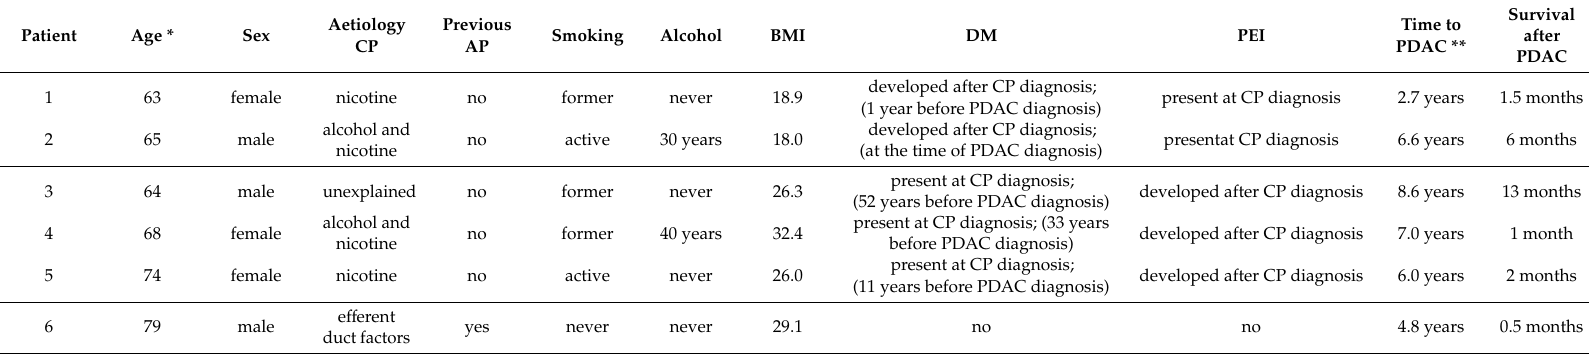
Table 2. Demographic and clinical characteristics of patients in whom pancreatic ductal adenocarcinoma occurred more than 2 years after the diagnosis of chronic pancreatitis.